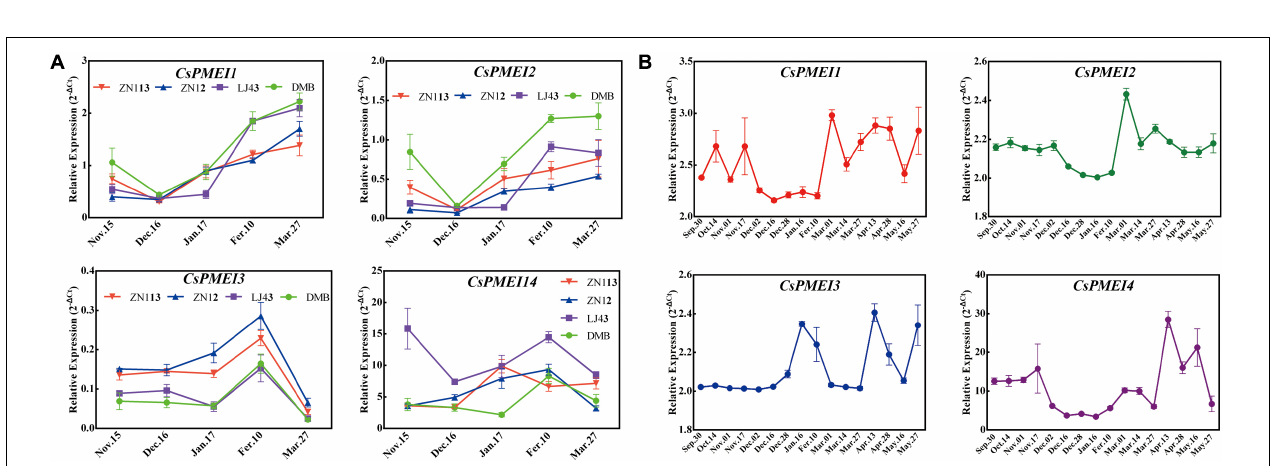
FIGURE 4 | Expression analysis of CsPMEIs during CA and bud dormancy periods. (A) Expression analysis of CsPMEIs in the mature leaves of four-tea cultivars during CA periods. ‘DMB,’ ‘LJ43,’ ‘ZN12,’ and ‘ZN113’ mean ‘DaMianBai,’ ‘LongJing43,’ ‘ZheNong12,’ and ‘ZheNong113’ tea plant cultivar, respectively. The relative expression levels were calculated by using 2 - (cid:49) Ct method. Data are shown as the means ± SE ( n = 3). (B) Expression analysis of CsPMEIs in axillary buds of ‘LJ43’ cultivar during bud dormancy period. The relative expression levels were calculated by using 2 - (cid:49) Ct method. Data are shown as the means ± SE ( n = 3).